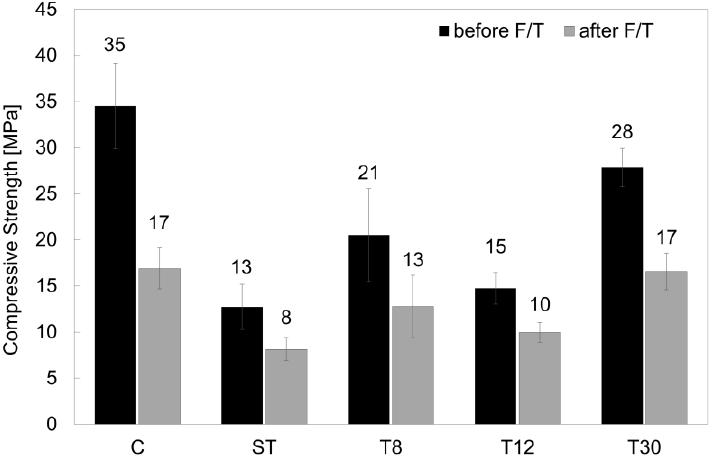
Figure 6. Compressive strengths of series C, ST, T8, T12 and T30 before and after freeze/thaw cycles. The error bars represent the standard deviation.